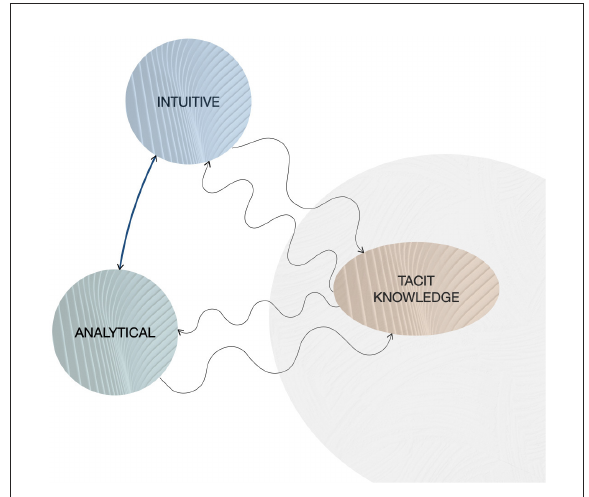
FIGURE1 A schematic representation of Knowledge. Tacit knowledge is involved in both intuitive and analytical reasoning, yet it is more heavily used in the former while in the latter it is only slightly adopted. An example of the application of tacit knowledge in analytical reasoning could come from the field of data analysis, where we can recognize the action of tacit knowledge in the choice of the model to use to analyze collected data. In both cases it is a fast process: tacit knowledge is immediately available and instantaneously applied by the individual. On the other hand, both intuitive and analytical approaches, thanks to the experience they bring to the individual, contribute to the slow process of knowledge sedimentation that creates an individual’s unique implicit knowledge. These aspects are represented in the image by links: the fast ( slow ) characteristic is figuratively represented by waves with a high (low) frequency. Their amplitude represents the weight of the influence between tacit knowledge and analytical/intuitive reasoning and, on the contrary, the influence of analytical/intuitive approaches on tacit knowledge. Moreover, the characteristic of tacit knowledge that can be neither explicitly declared nor open to introspection is represented by the haziness of its area. The last arrow, between analytical and intuitive, stands for the continuously evolving relationship between these two individual modalities, which has a speed of change entirely depending on individual